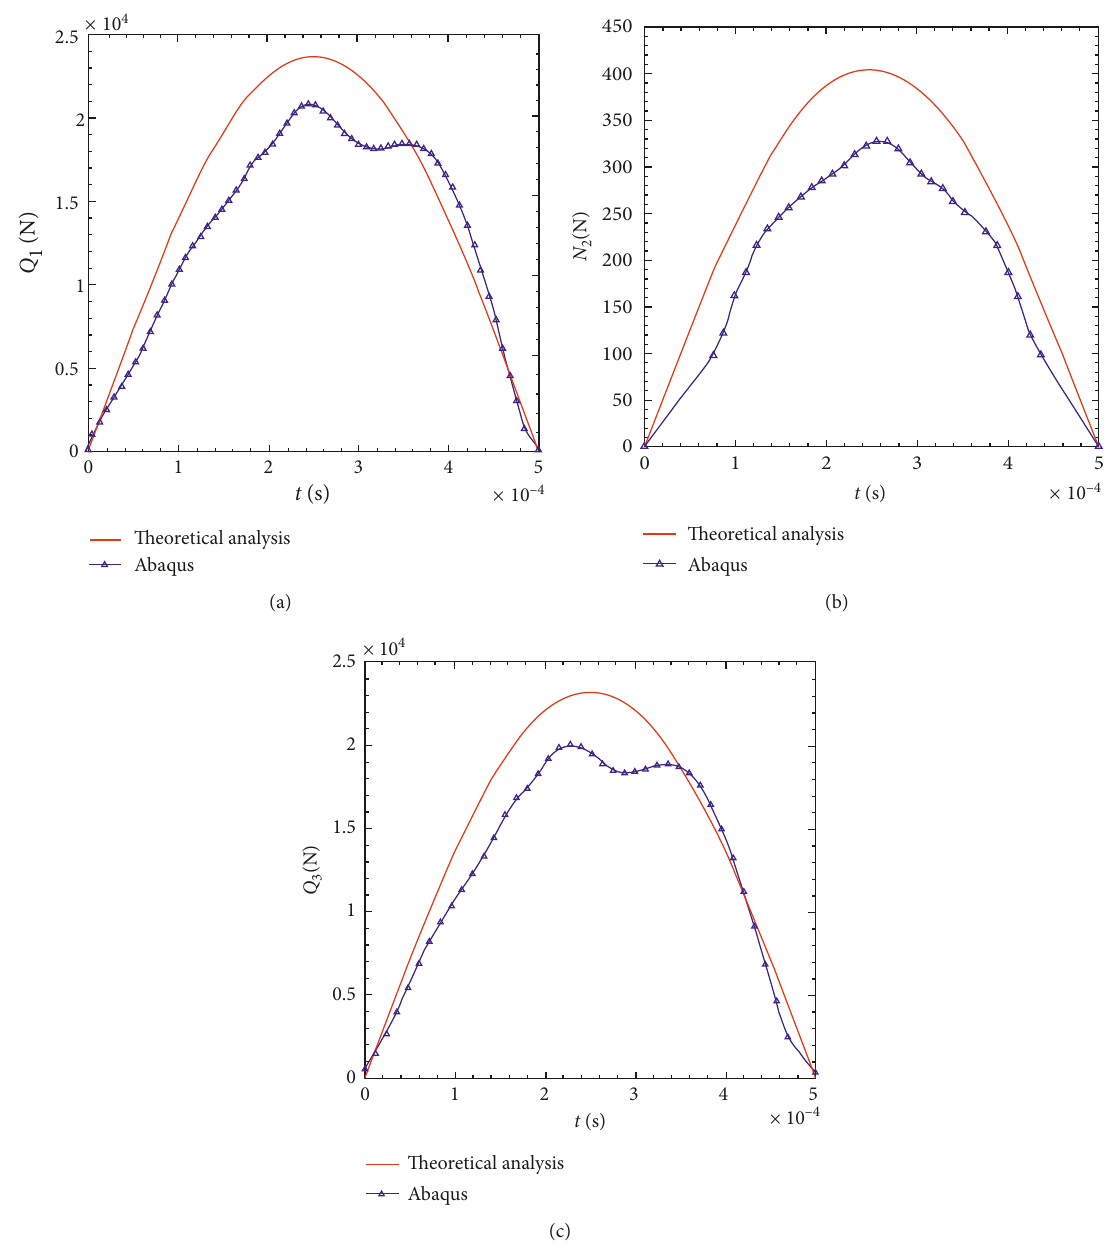
Figure 3: The internal force by two methods ( α